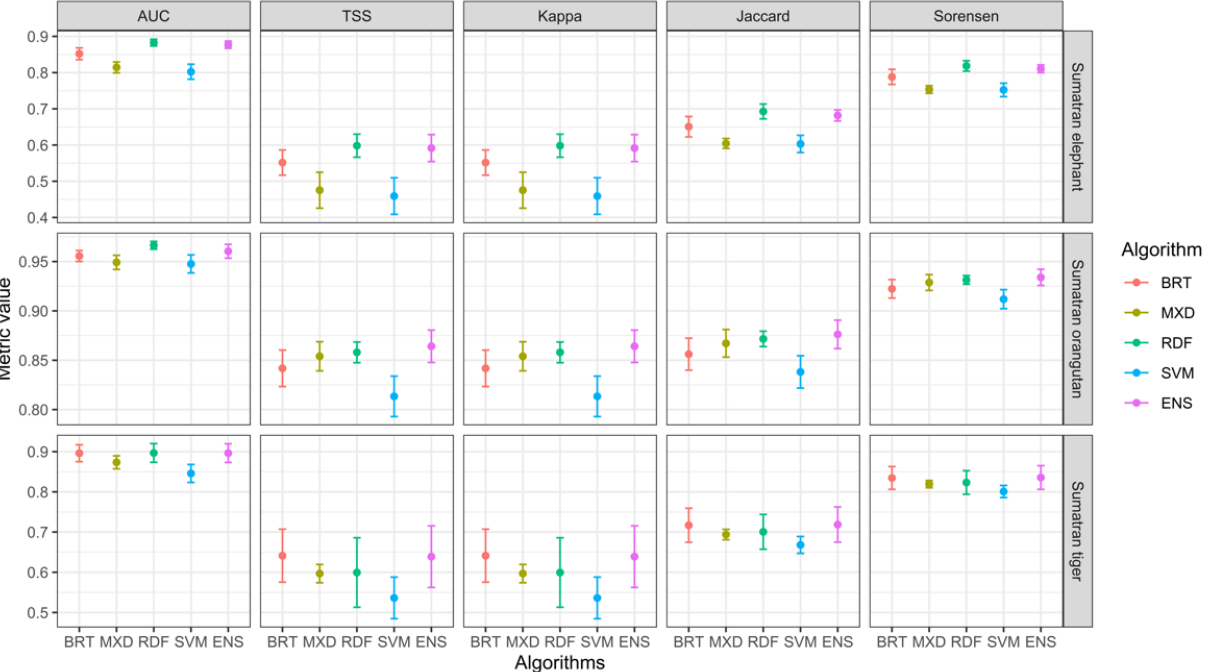
Figure 1. Model evaluation for Sumatran elephant, orangutan, and tiger for various algorithms using discrimination metrics.